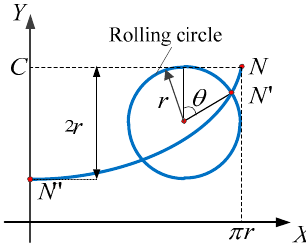
Figure 5. Schematic diagram of forming a cycloid.